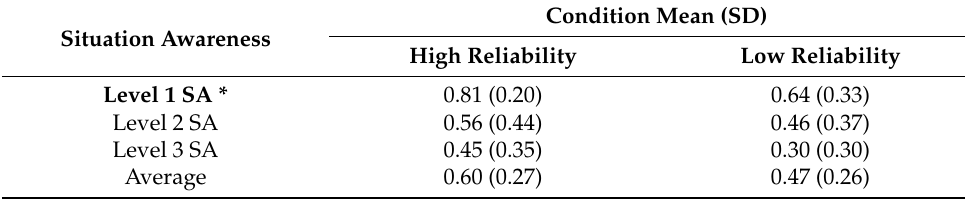
Table 9. SAGAT result (mean and standard deviation).